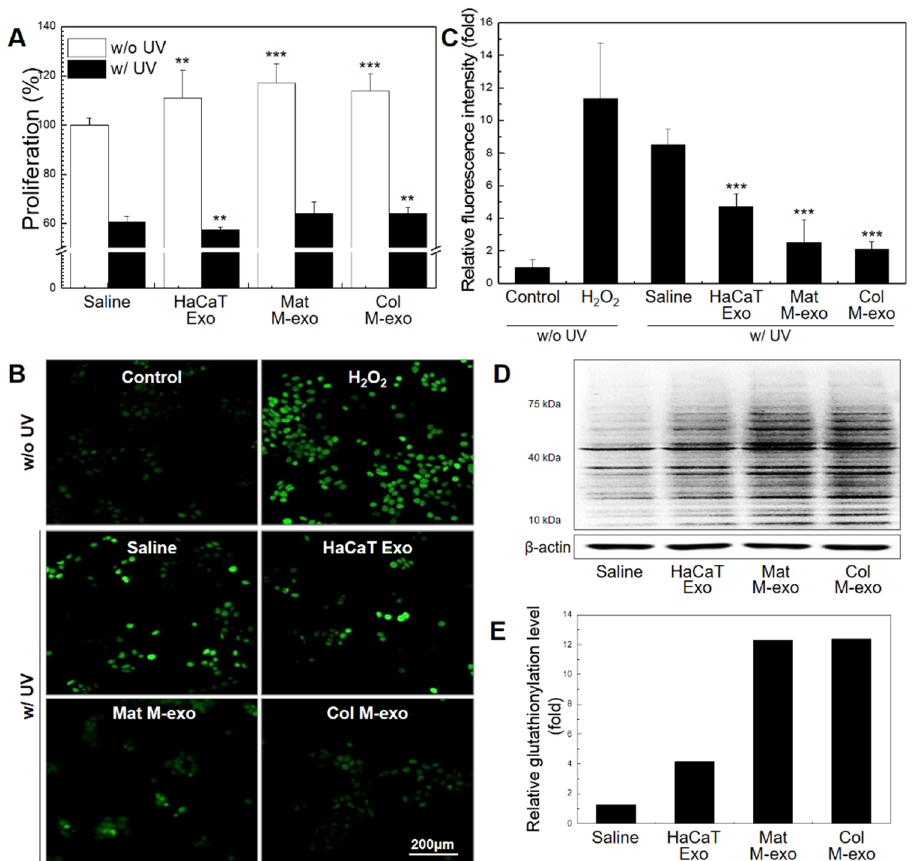
Figure 3. Antioxidant effect of milk exosomes on oxidative damage in HaCaTs. ( A ) Evaluation of cell proliferation rate of milk exosomes on HaCaTs was assessed by CCK-8 analysis. n = 5; ** p < 0.01, and *** p < 0.001 compared saline. ( B ) HaCaTs were pretreated with exosomes at a concentration of 0.05 mg/mL for 12 h. After UV irradiation, intracellular ROS levels were measured by DCF-DA assay. Scale bar: 200 µ m. ( C ) Relative fluorescence intensity of intracellular DCF-DA. n = 3; *** p < 0.001 versus saline. ( D ) Western blot analysis of s-glutathionylated proteins. ( E ) Relative glutathionylation level using β -actin for normalization.